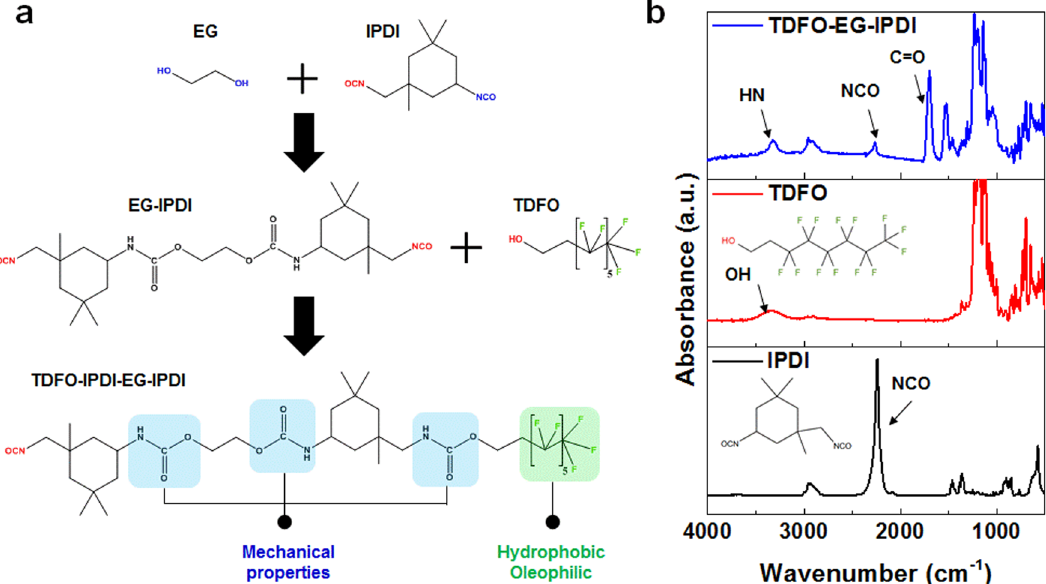
Fig. 2 Synthesis of in-and-out F-PU coating materials. a Schematic illustration of F-PU coating materials with the fl uorination and urethane bonding of ethylene glycol (EG), isophorone diisocyanate (IPDI), and 1H,1H,2H,2H-Trideca fl uoro-1-n-octanol (TDFO) for the synthesis of the F-PU coating materials ( b ) Fourier transform-infrared (FT-IR) transmittance of the F-PU coating materials (TDFO-IPDI-EG-IPDI), TDFO, and